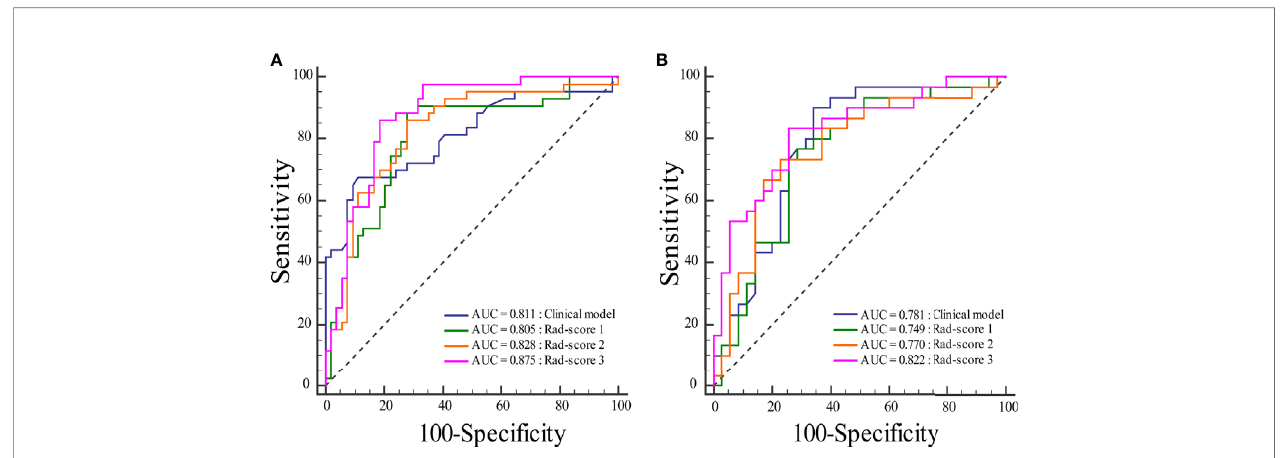
FIGURE 3 | Comparisons of the ROC curves for the clinical model and three rad-scores in each cohort. (A) The ROC curves for the clinical model and three rad- scores in the training cohort. (B) The ROC curves for the clinical model and three rad-scores in the validation cohort.